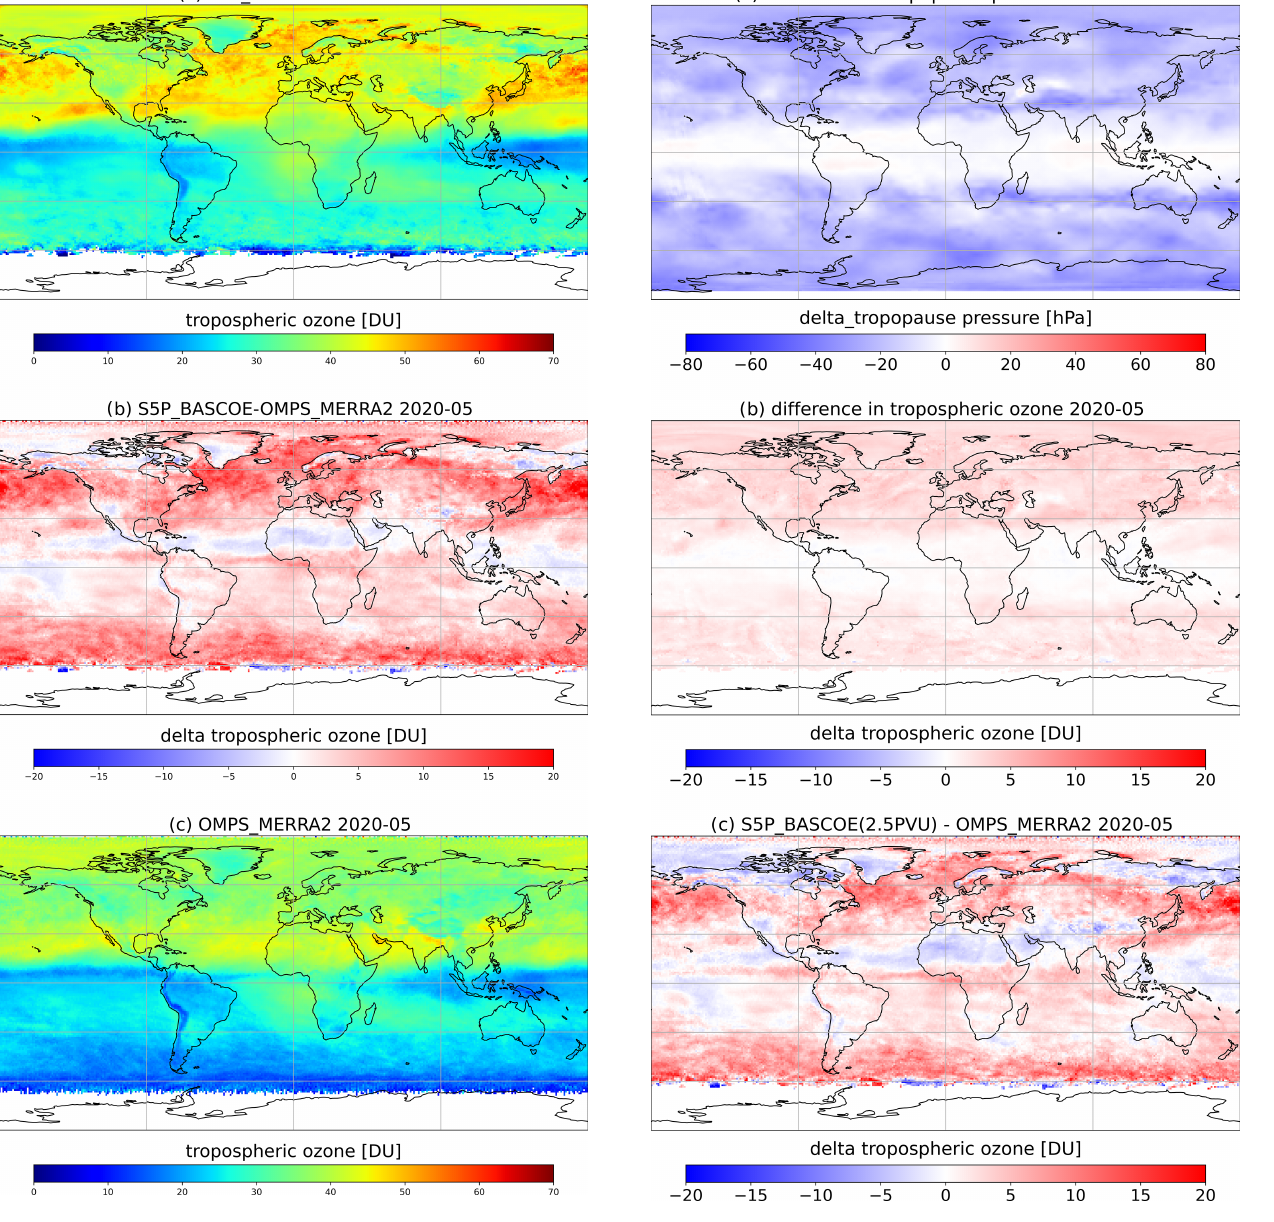
Figure 7. Difference in the BASCOE tropopause pressure P tropopause (3.5PVU)– P tropopause (2.5PVU) (a) and the respective tropospheric ozone columns (b) for May 2020. Panel (c) shows the difference from OMPS-MERRA-2 (compare Fig. 6b) when using the 2.5PVU